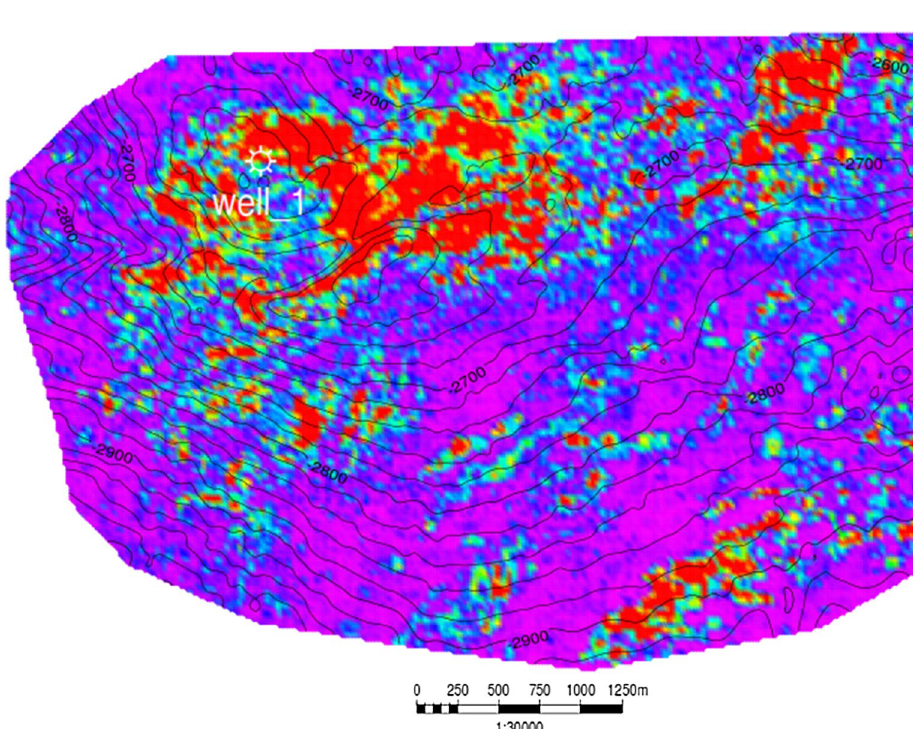
Fig. 6 Far-minus-near attribute superimposed on a two-way time contour